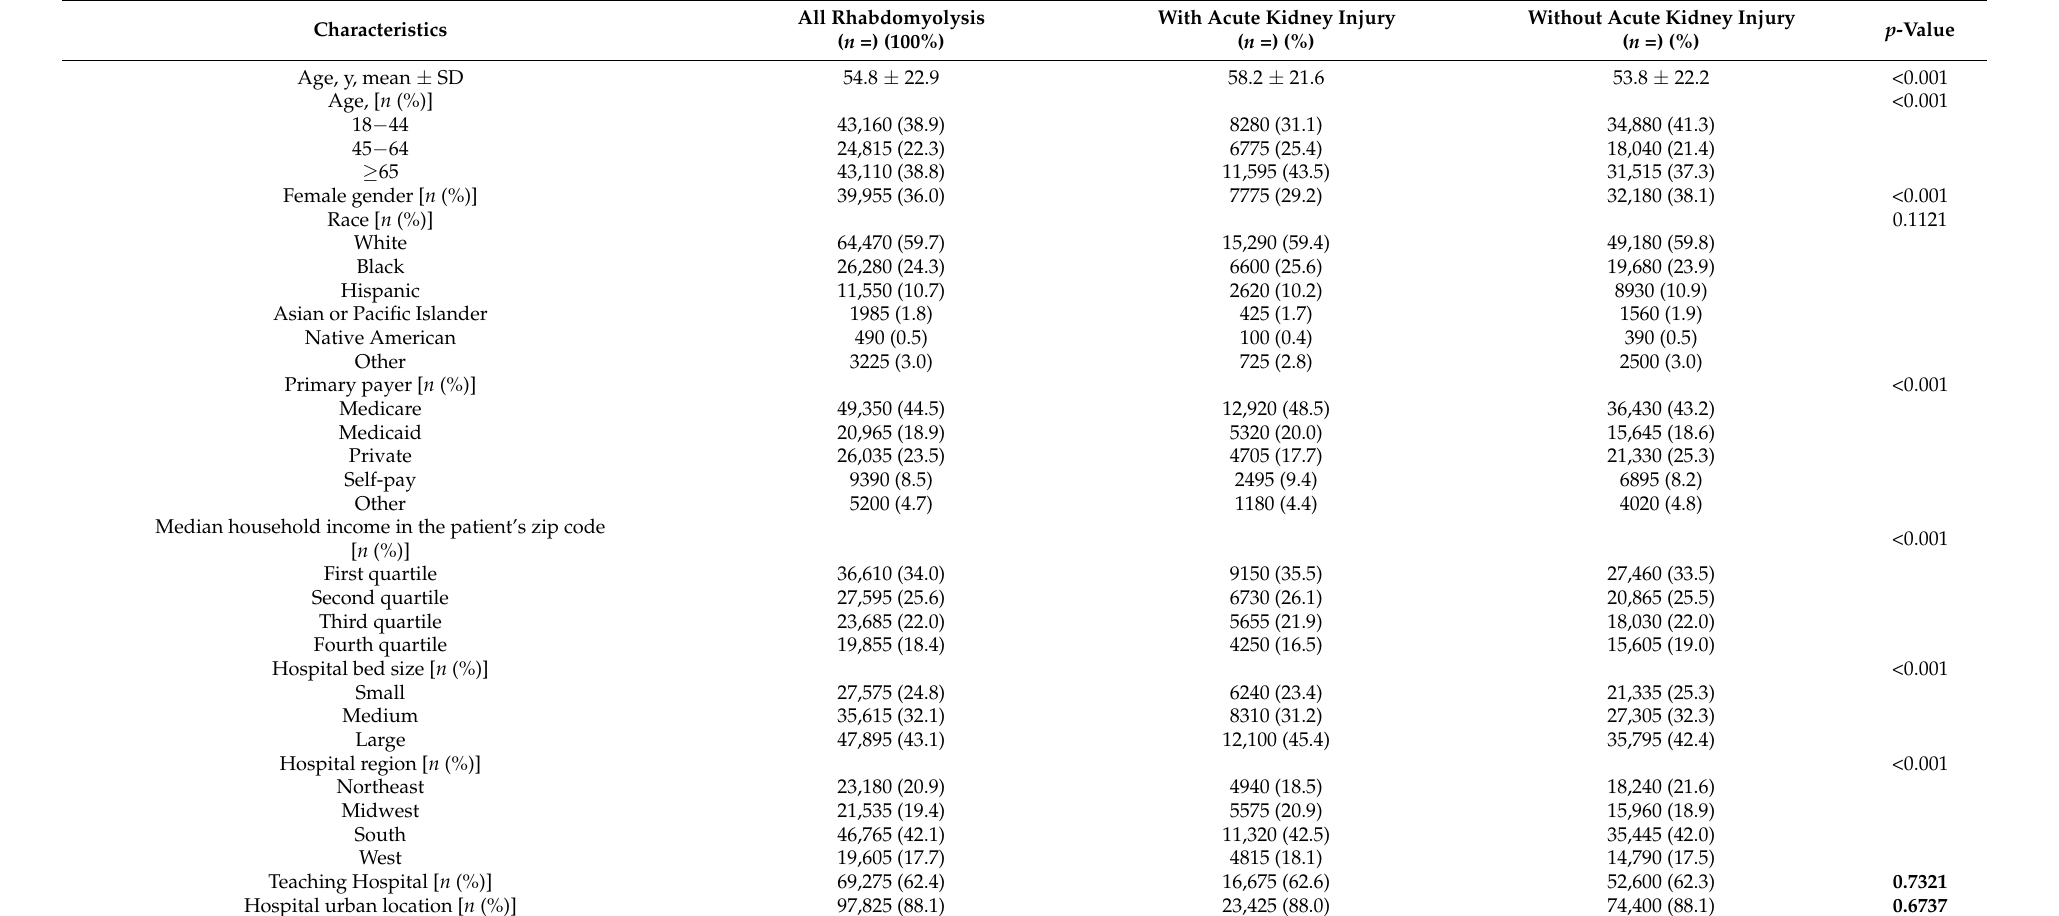
Table 1. Baseline characteristics of rhabdomyolysis-related hospitalizations with and without